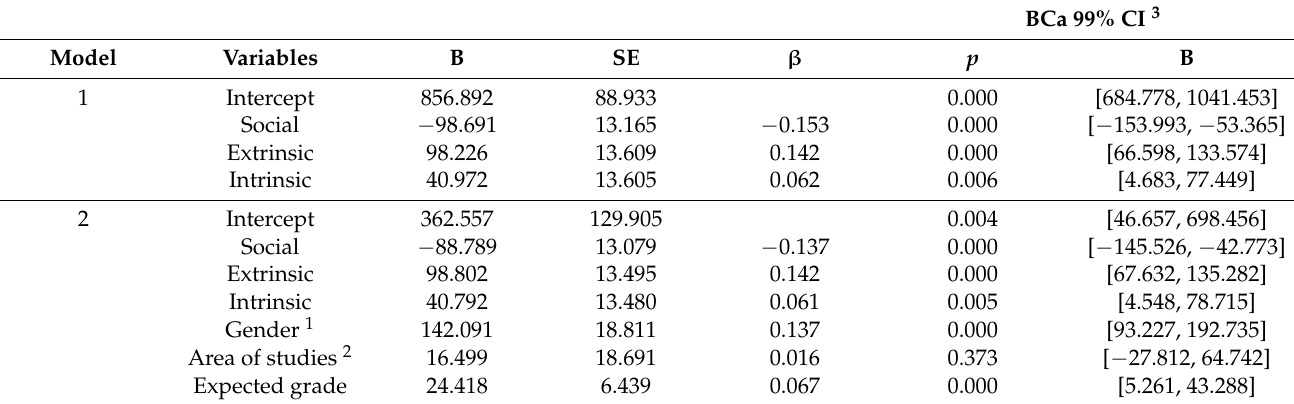
Table 6. Multiple linear regression for expected entry salary.